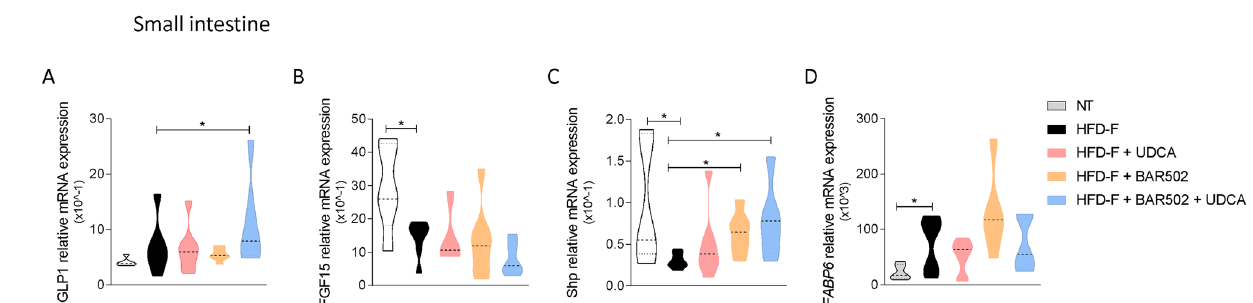
Figure 7. Relative mRNA expression of ( A ) pro-glucagon precursor, ( B ) FGF-15, ( C ) Shp and ( D ) FABP6 in small intestine samples. Data are normalized to Gapdh mRNA. Each result is the mean ± SEM of 7–11 mice per group. *p ≤